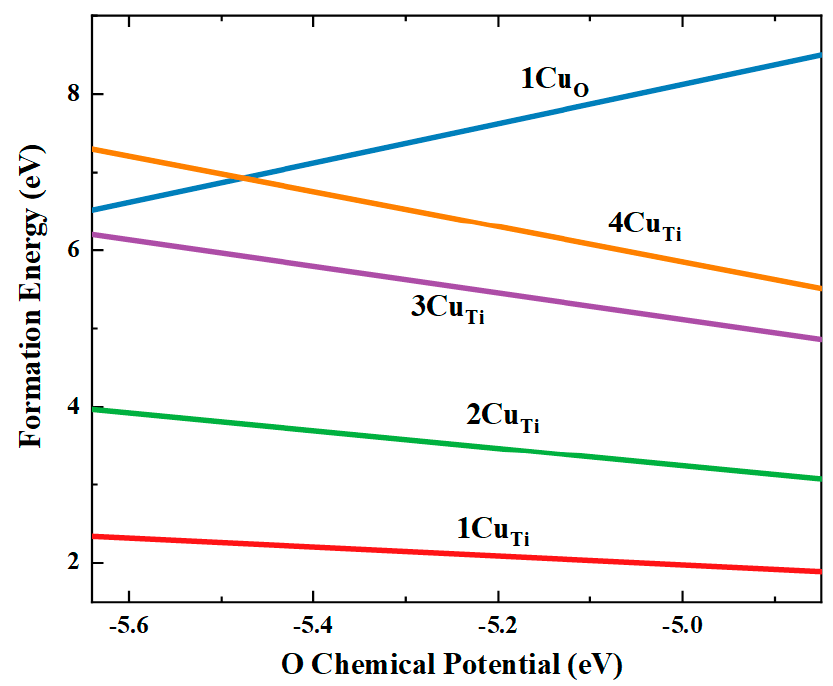
Figure 2. Predicted energies of formation versus the oxygen chemical potential for Cu doping con-